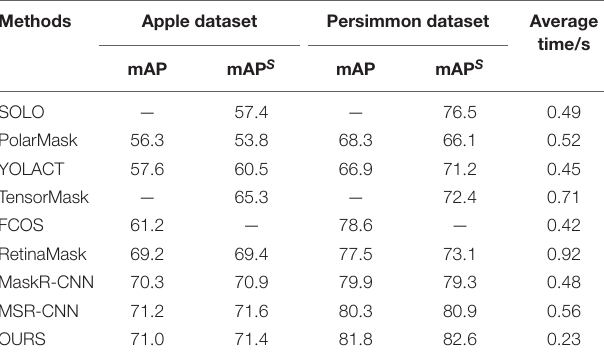
TABLE 3 | Performance comparison of detection and segmentation